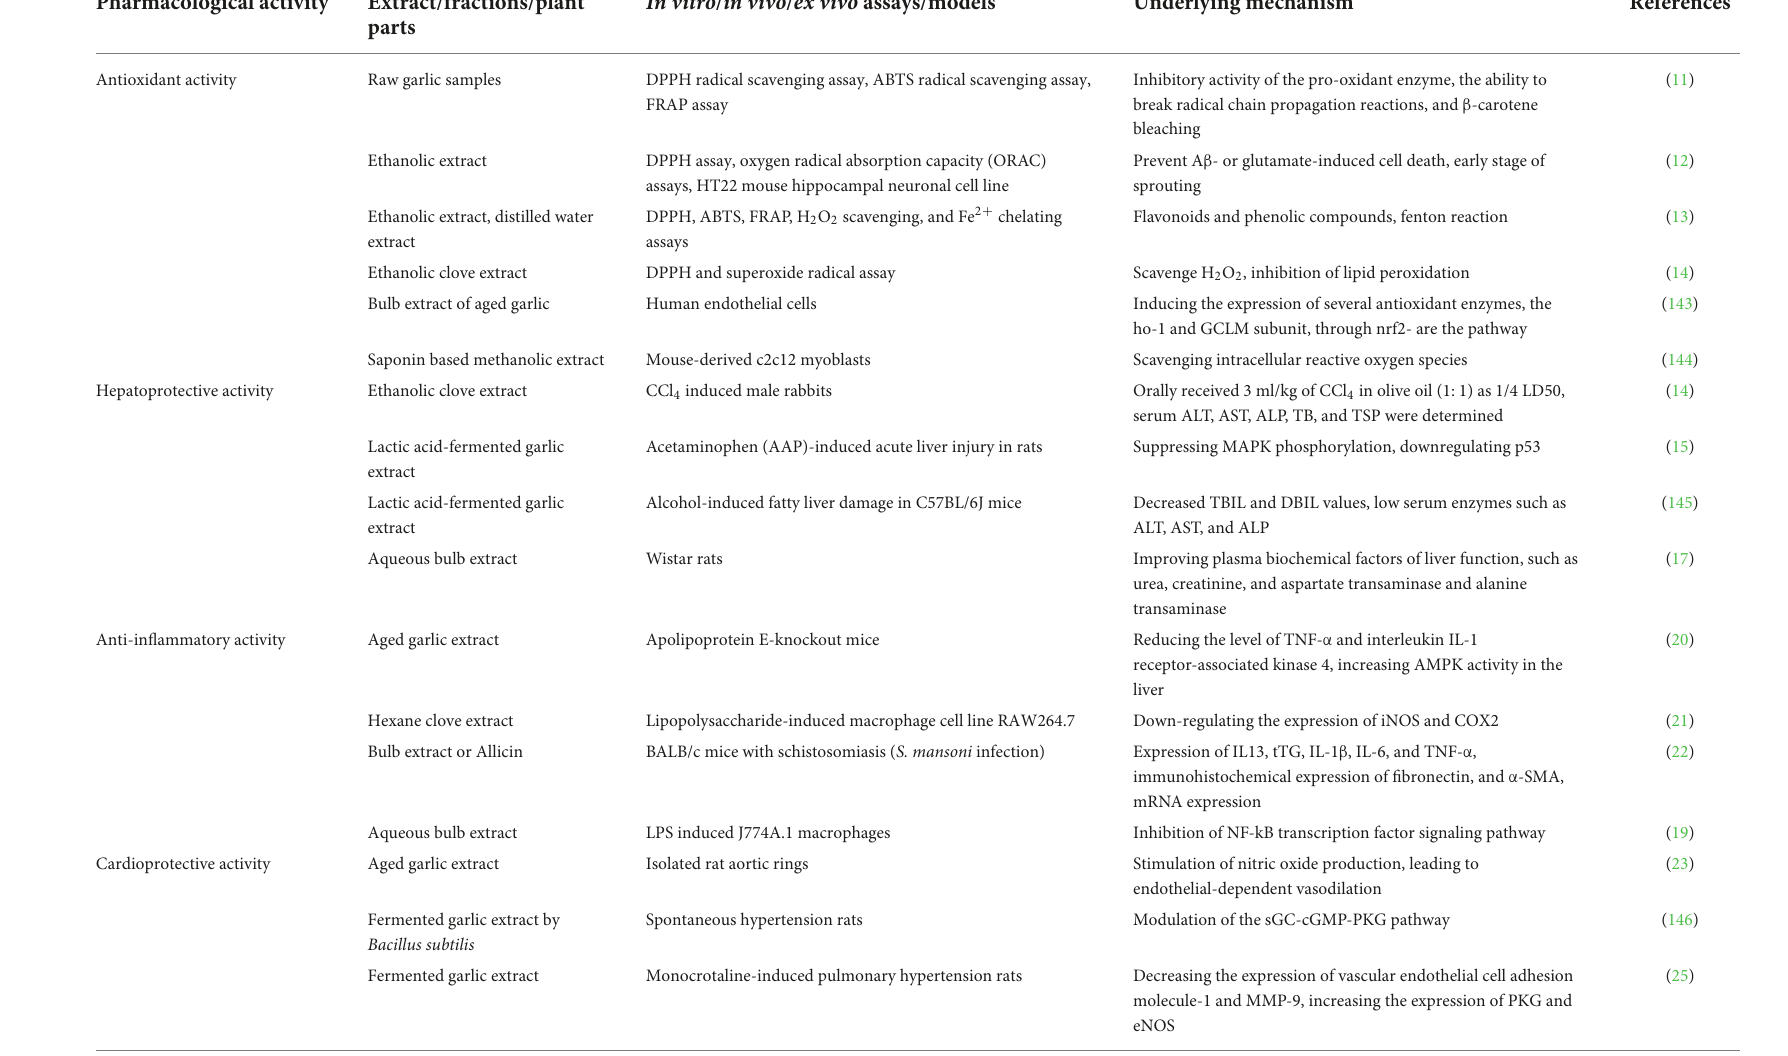
TABLE 2 Pharmacological investigations of A. sativum